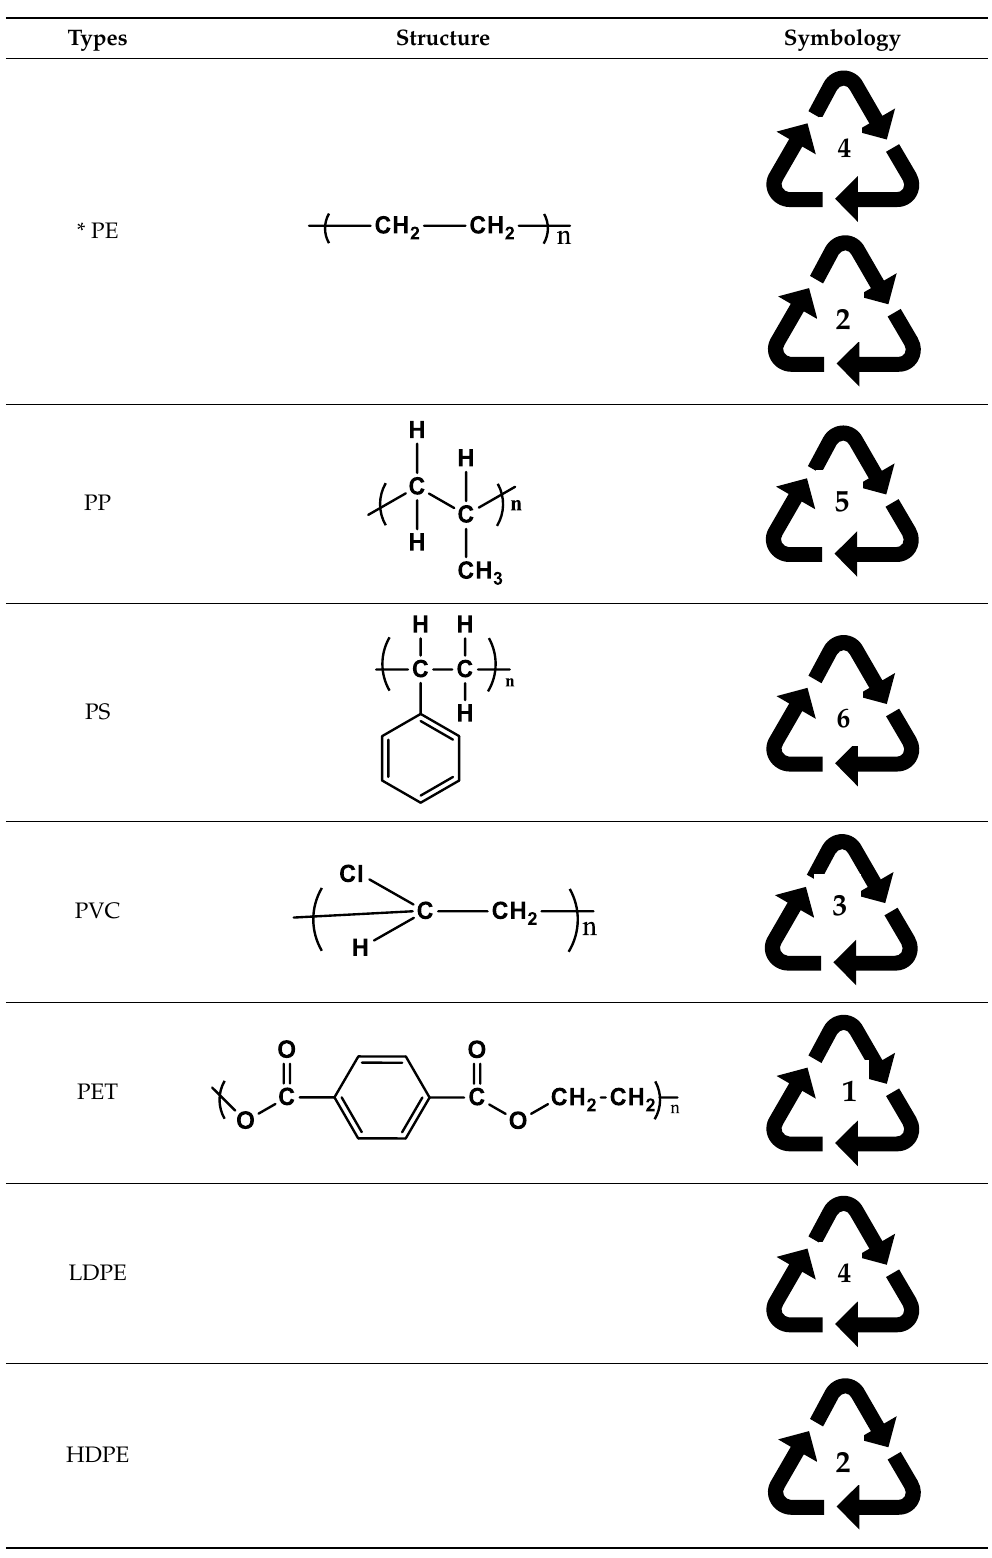
Table 1. Types of plastics, chemical structure, and symbology (Miandad et al. 2017) [47].